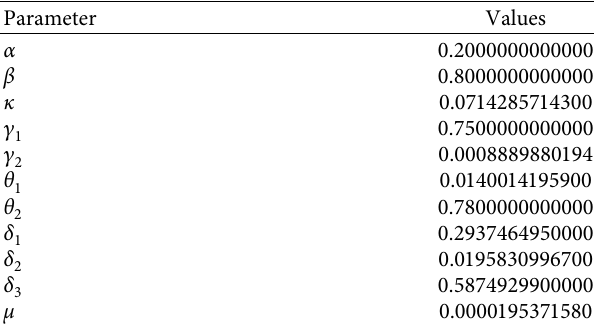
Table 3: List of parameters for the model.